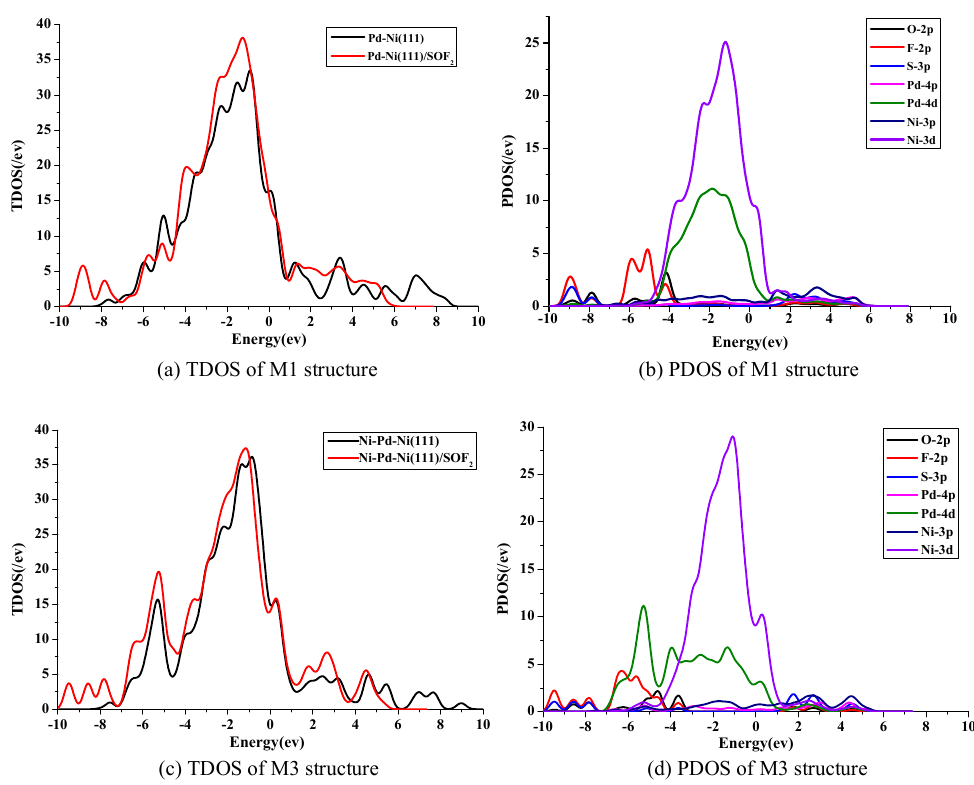
Figure 3. ( a , c ) Total density of states (TDOS), ( b , d ) partial density of states (PDOS) for the structure of Figure 3. ( a ) and ( c ) Total density of states (TDOS), ( b ) and ( d ) partial density of states (PDOS) for the M1 and M3. structure of M1 and M3.